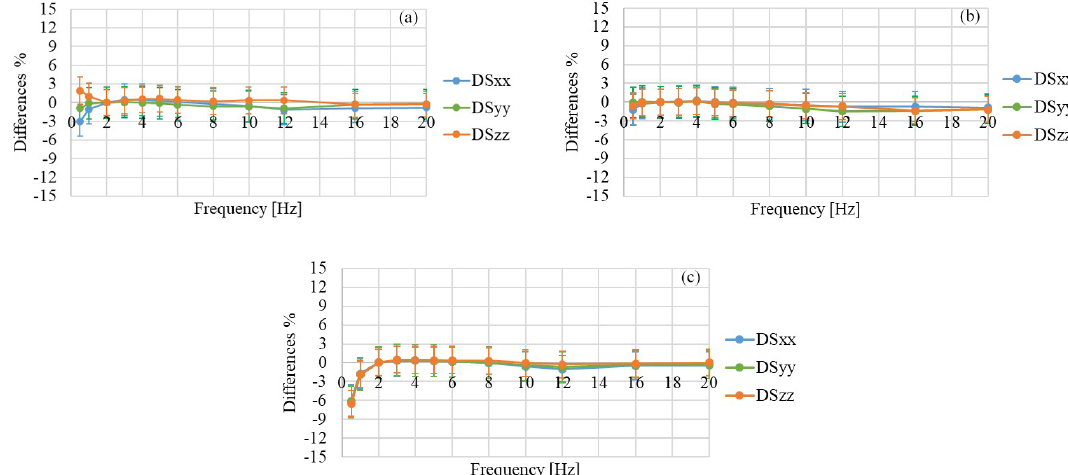
Figure 8. Sensitivity differences for the MEMS capacitive accelerometer: (a) analog input module; (b) IEPE module, DC coupled mode; (c) IEPE module, AC coupled mode.